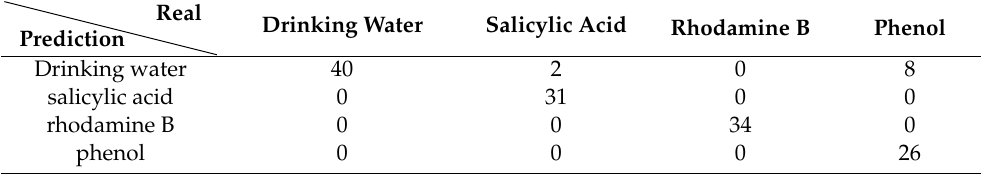
Table 4. Qualitative discrimination results of groups A and B based on the improved algorithm. Prediction